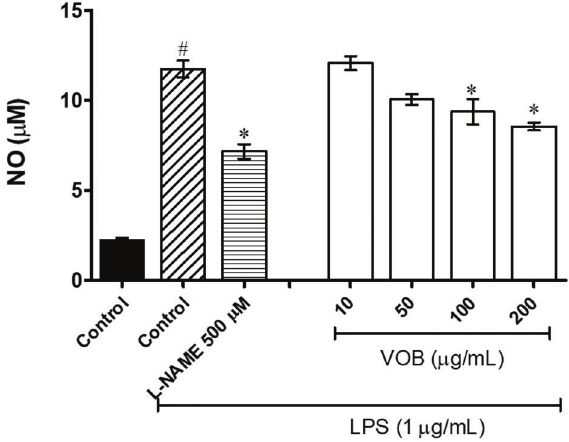
Figure 3. Inhibitory effects of vegetable oil blend (VOB) on nitrite production of lipopolysaccharide (LPS)-activated RAW 264.7 cells. LPS (1 m g/mL) with or without VOB (10 to 200 m g/mL) was added to cells and nitrite concentration was measured by Griess reaction assay. Data are reported as means ± SE of triplicate experiments. *P o 0.05 compared with the LPS-treated group. # P o 0.05 com- pared with the unstimulated control group (ANOVA and the Tukey ’ s post-hoc